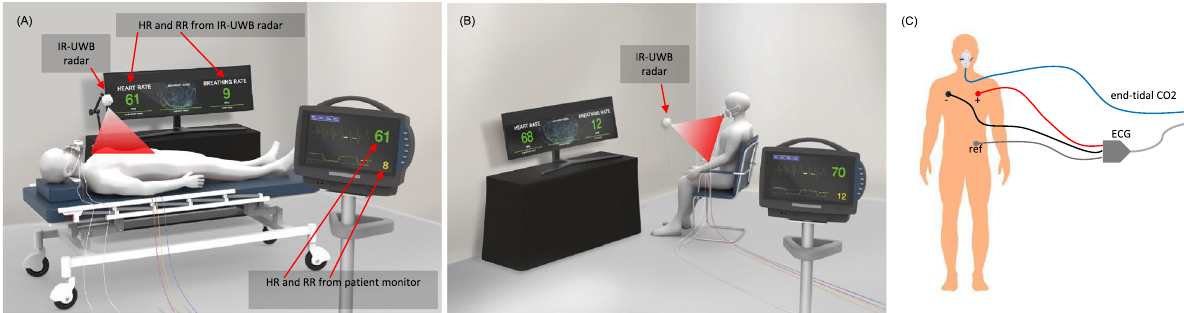
Figure 1. The graphical description of the experiment environment. HR and RR were measured simultaneously using an IR-UWB radar sensor and a patient monitor in both supine ( A ) and sitting ( B ) positions. ECG and capnometry was obtained using the patient monitor to determine the reference values of HR and RR respectively. ECG and the capnometry setup is described in ( C ). The measurements of HR and RR